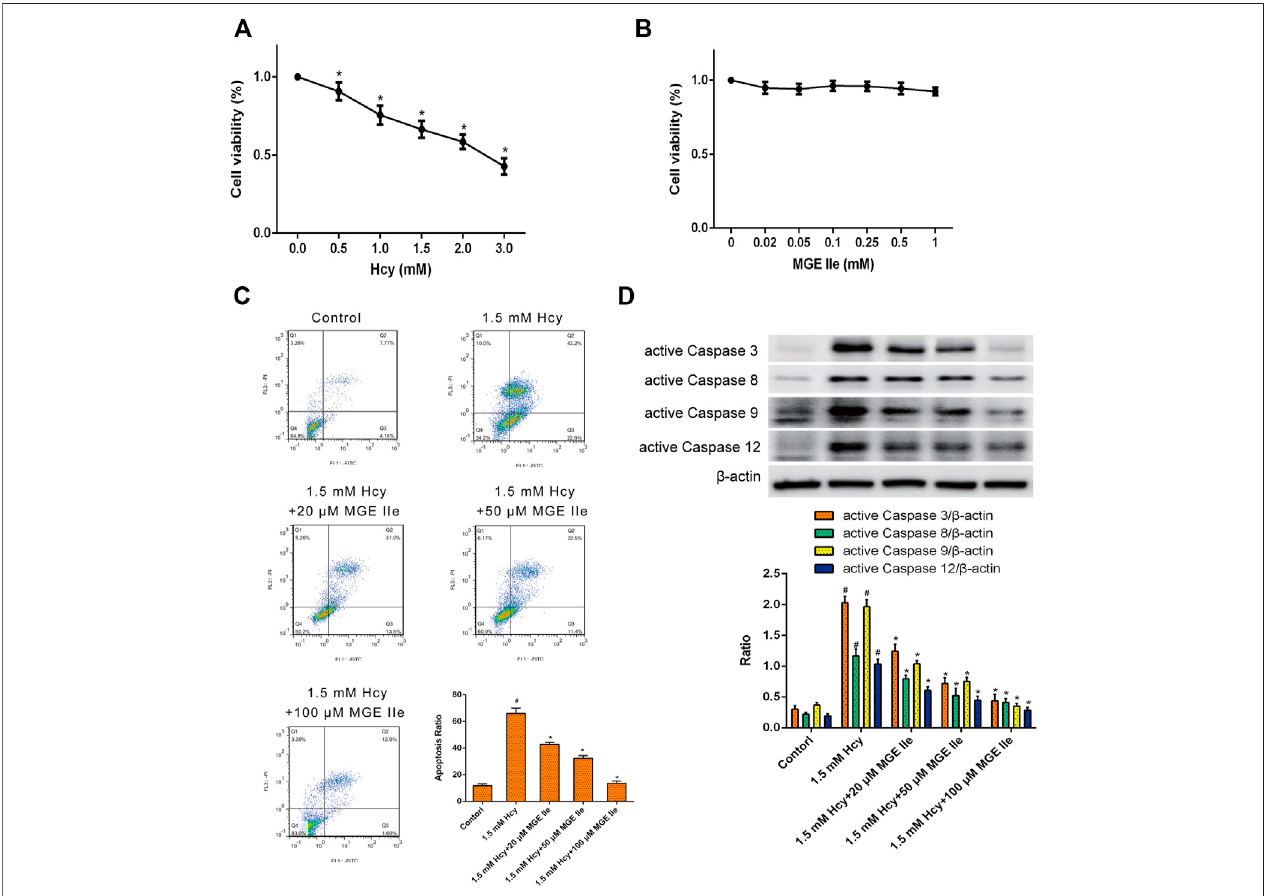
FIGURE 4 | MGE IIe inhibits the apoptosis of H9c2 cells induced by Hcy. (A) The effect of Hcy on H9c2 cell viability. (B) The effect of MGE IIe on the H9c2 cell viability. (C) Theeffect ofMGEIIeon theHcy-inducedH9c2 cellsapoptosismodel by fl owcytometry. (D) Theeffect ofHcyontheactivity ofcaspase-3, -8,-9,and-12in H9c2cells.One-wayANOVAwasfollowedbyposthoctestsforcomparisonsamonggroups.Thevaluesshownrepresentthemean ± standarderrorofthemean(SEM) of the data from three independent experiments. # p < 0.05 (compared to the control group alone); * p < 0.05 (compared to the model group alone).